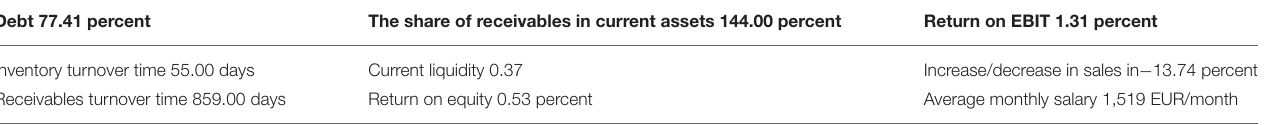
TABLE 5 | Economic indicators in